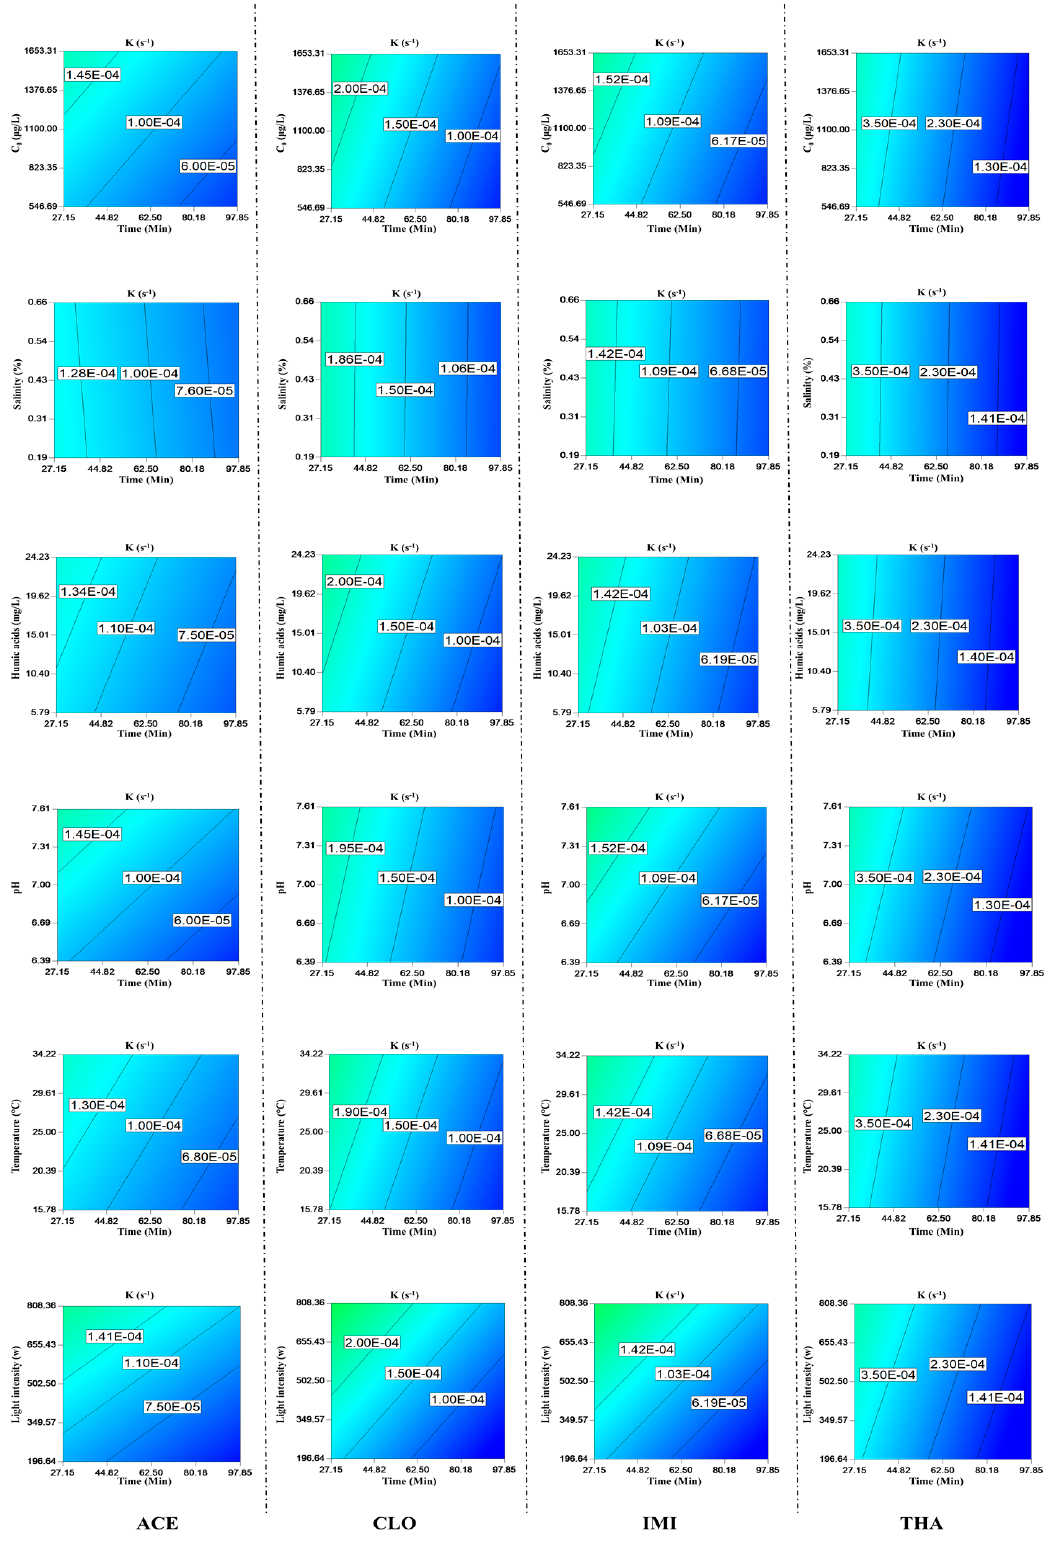
Figure 3. Photolysis of four typical NEOs and environment parameters affecting NEO photolysis